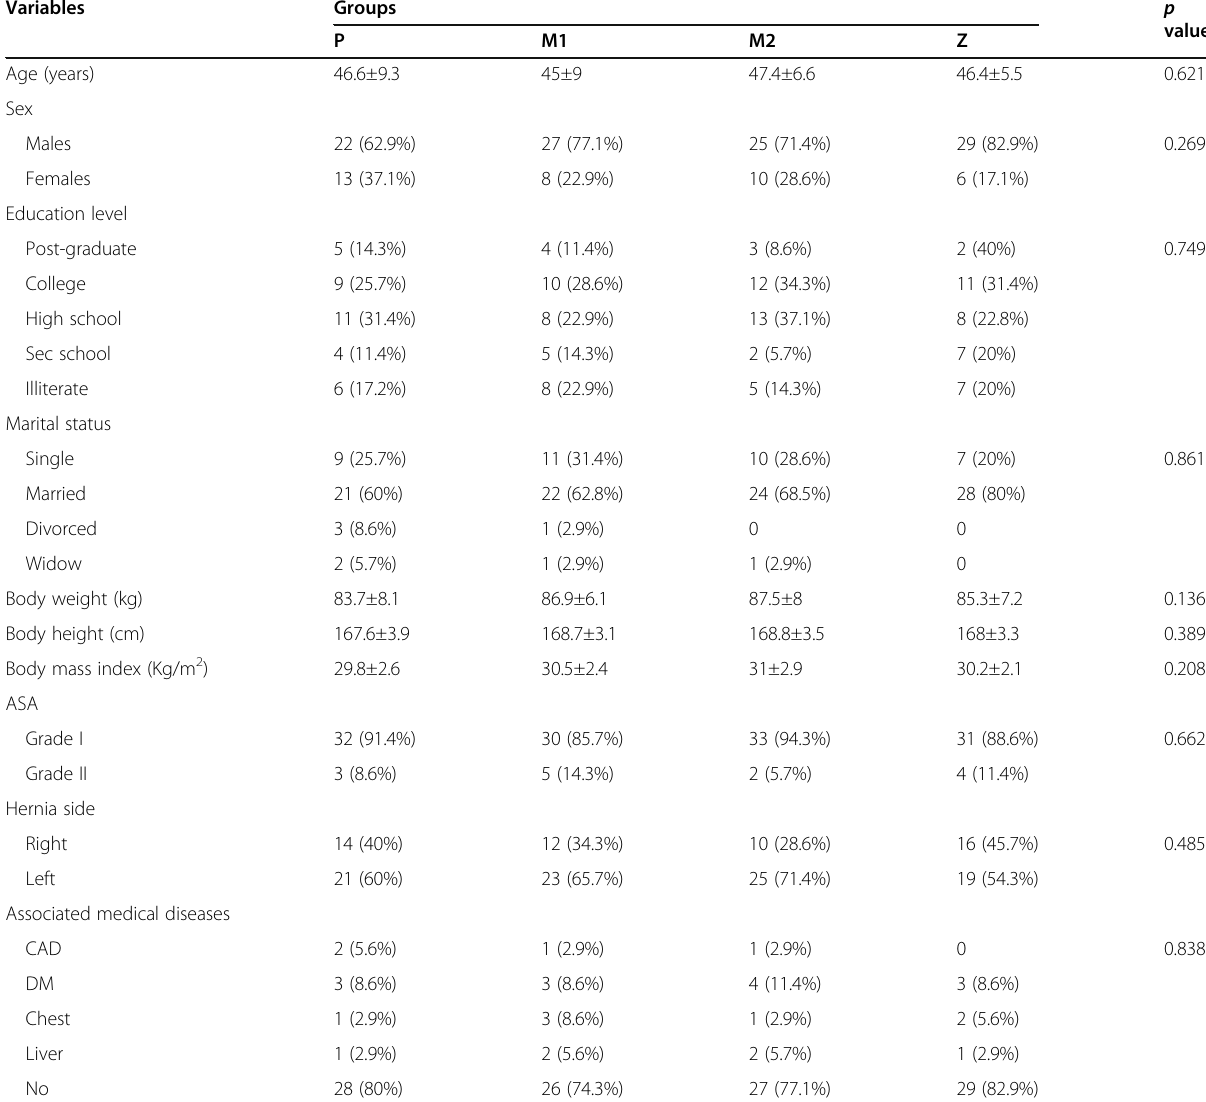
Table 1 Inclusion data of patients of the four groups Variables